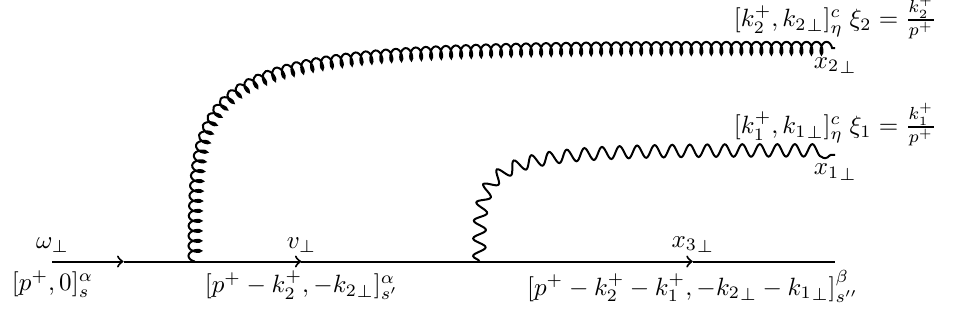
Figure 1 . The (cid:12)rst component of the dressed quark wave function eq. (2.1) where the photon is emitted before the gluon.